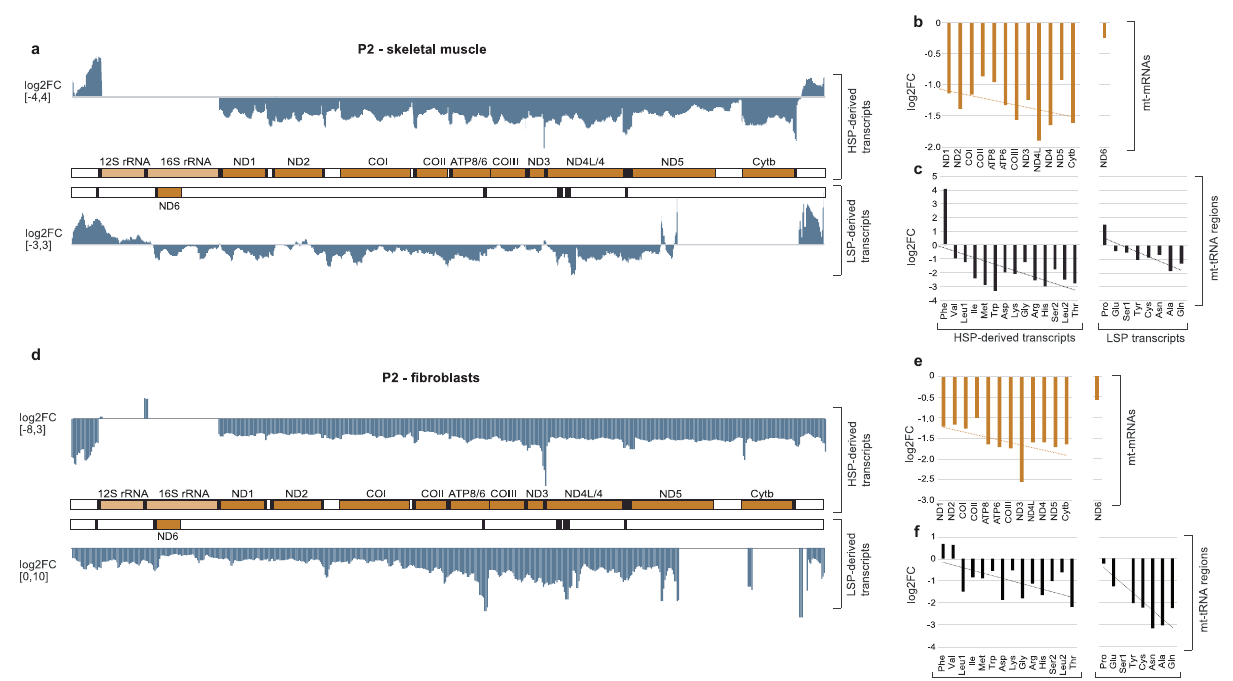
Fig. 5 | Mitochondrial transcriptome in TEFM patients. a Transcriptome-wide RNA-Seq analysis showing the effects of TEFM loss in skeletal muscle of patient 2 (P2)on mtRNA transcripts. A mapof mtDNA showing the changeinsequence read coverage (log 2 fold change between patient 2 and two healthy controls) on both strands. b Quanti fi cation of the difference in reads per gene between skeletal muscle from P2 and from two healthy controls ( n =3 technical replicates) for mt- mRNA derived reads for both strands, from proximal to distal from the promoter and c reads corresponding to mt-tRNA for both strands in the order they are transcribed ( n =3 technical replicates) d Transcriptome-wide RNA-Seq analysis of